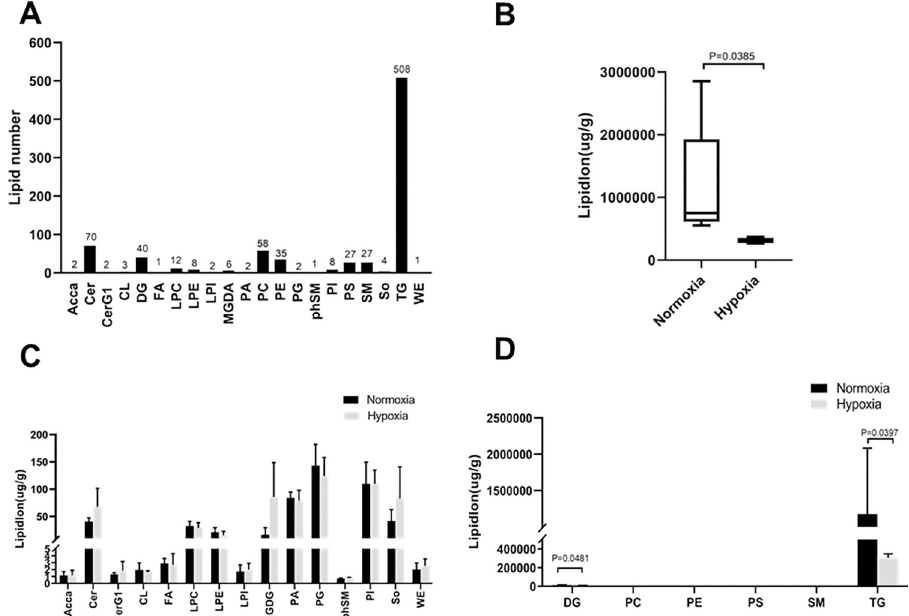
Fig 2. Changes in lipids in the hypoxia group versus the normoxia group. Lipids were classified according to the guidelines of the International Lipid Classification and Nomenclature committee. (A) Number of lipid classes and lipid species, (B) total lipid molecular content, and (C and D) content of different lipid subgroups. Independent-samples t- test was used for the statistical analysis of data presented in panels B, C, and